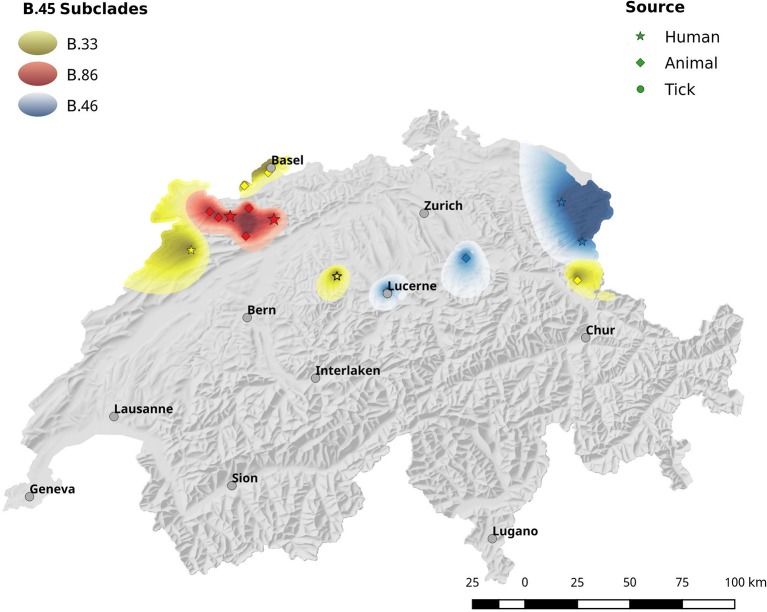
Same as Figure 4.